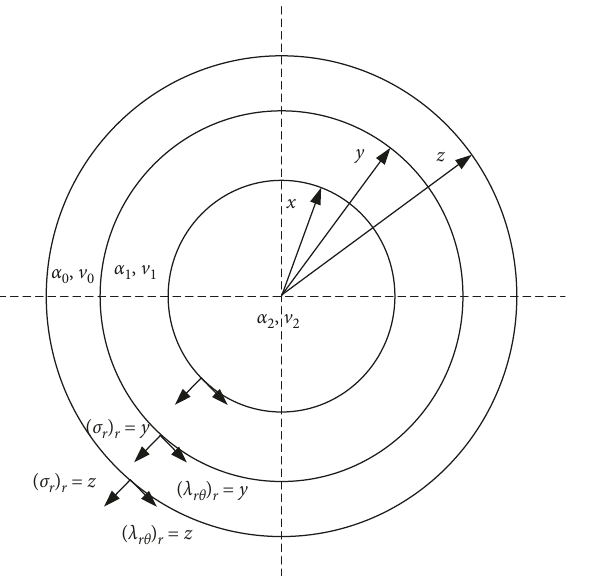
Figure 7: Mesoscopic model of elastic modulus